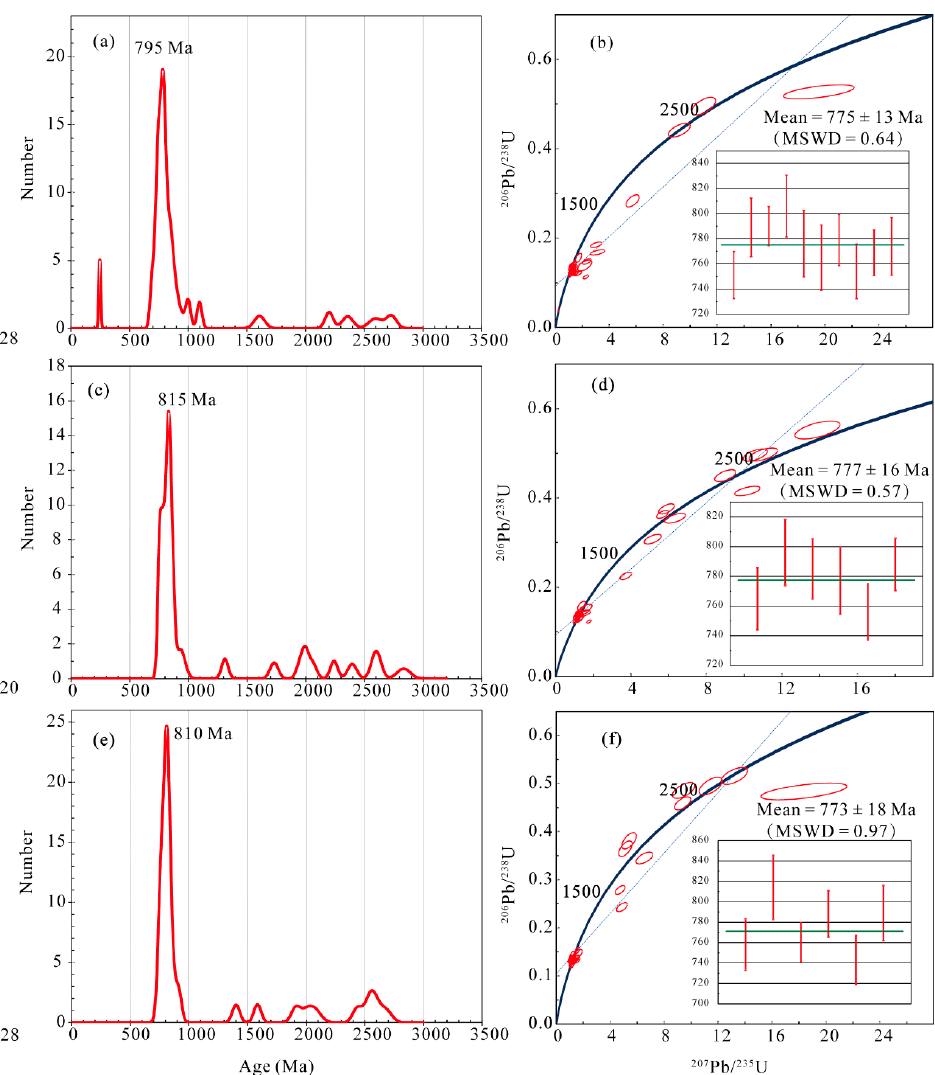
Figure 6. Historgams, Concordia and weighting mean ages of zircon grains from represented samples. ( a ) and ( b ) are of tuffaceous slate; ( c ) and ( d ) are of sandy slate; ( e ) and ( f ) are of gold-bearing quartz vein.